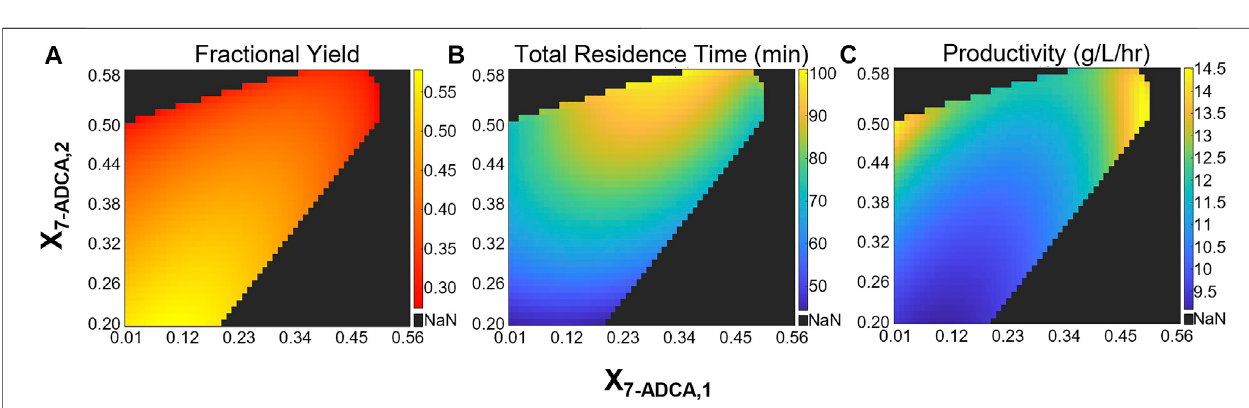
FIGURE6| Heatmaps showingthe (A) fractional yield (B) productivity and (C) total residence time fora CSTR +CSTR system at various combinations of7-ADCA conversions in each reactor. The x -axis shows the total conversion reached in the fi rst CSTR and the y -axis shows the total 7-ADCA conversion exiting reactor two assuming an inlet 7-ADCA concentration of 100 mM and inlet PGME concentration of 250 mM. The AEH concentration in both reactors is constant at 200 nM.